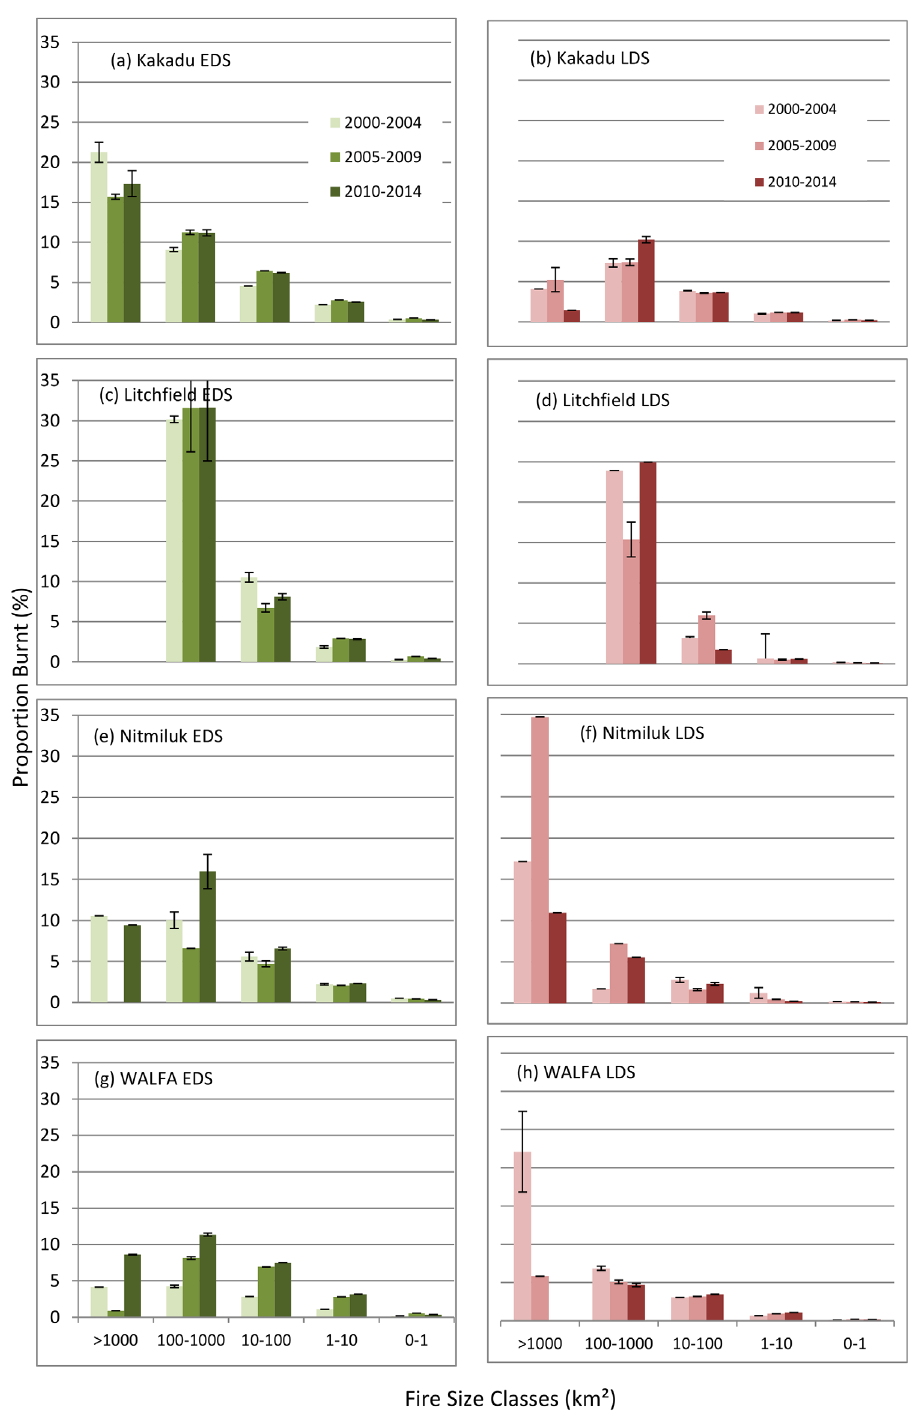
Fig 4. Mean early dry season (EDS) and late dry season (LDS) fire patch-size distributions ( ± S.E.M.) of contiguously burnt areas (CBAs) over successive five-year periods for the four study sites, expressed as the proportion of respective lowland and upland savanna